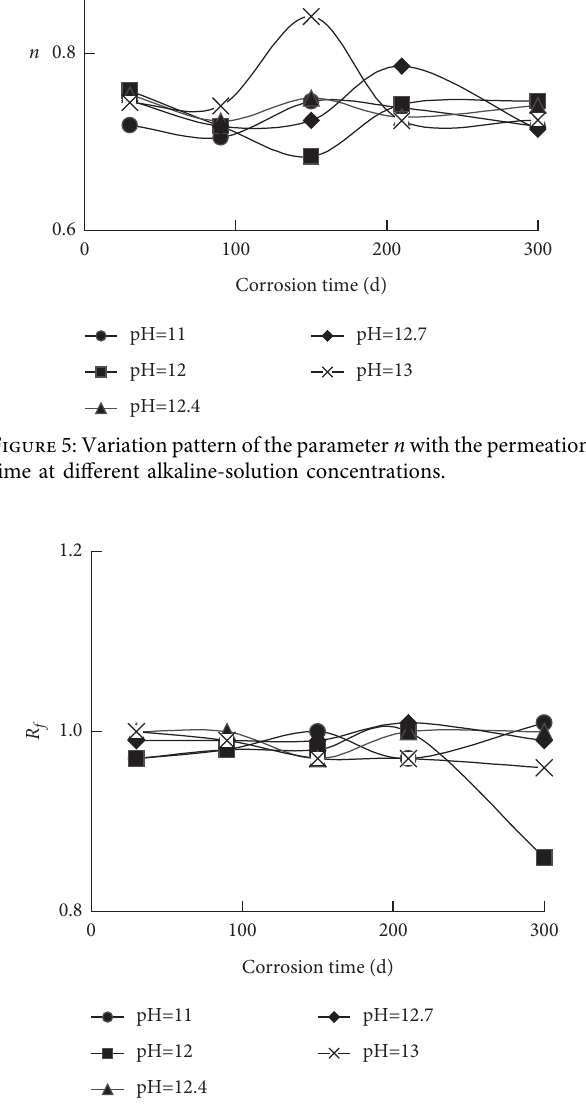
Figure 6: Variation pattern of the parameter R f with the perme- ation time at different alkaline-solution